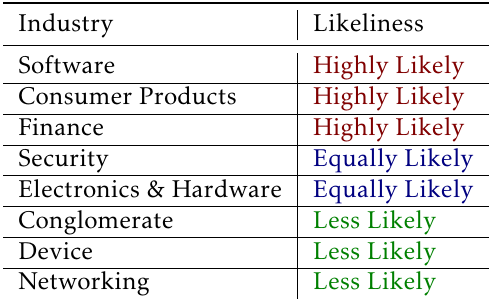
Table 2. Per industry stock impact likelihood